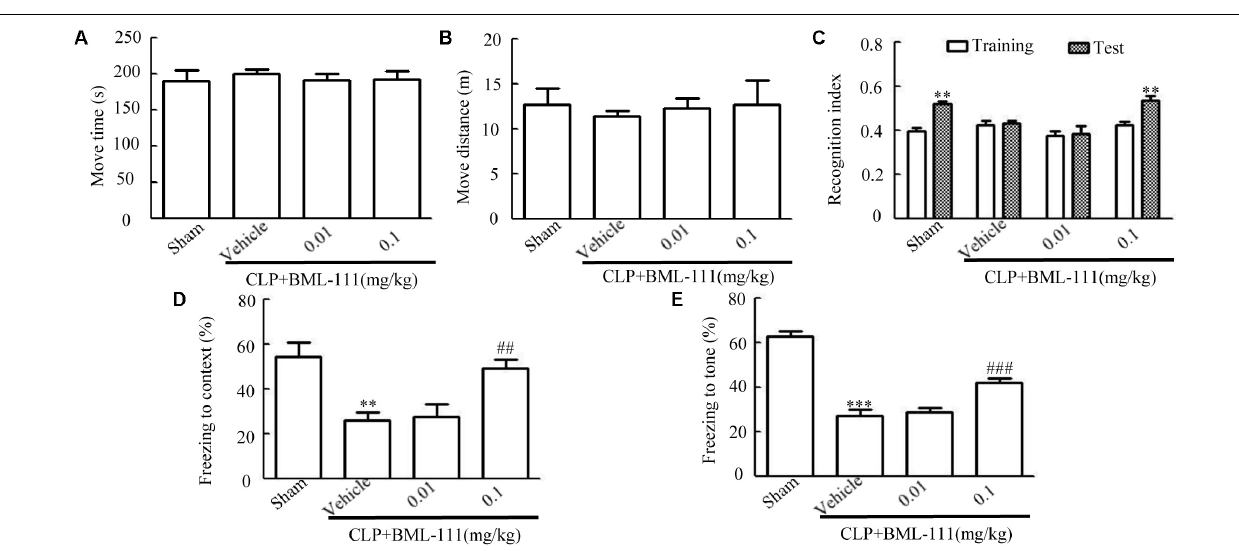
FIGURE 2 | Influences of BML-111 at different doses on cognitive dysfunction in mice with sepsis. BML-111 was injected intracerebroventricularly at doses of 0.01 and 0.1 mg/kg immediately after performing CLP. (A,B) No significant difference was observed in the move time and distance parameters in the open-field test. (C–E) Effects of BML-111 at different doses on novel-object-recognition and fear-conditioning tests results. Data were shown as the means ± SEM ( n = 10 surviving mice per group). ∗∗ P < 0.01 represents Test vs. Training in (C) . ∗∗ P < 0.01, ∗∗∗ P < 0.001 represent CLP + Vehicle vs. Sham and ## P < 0.01, ### P < 0.001 represents CLP + 0.1 mg/kg BML-111 vs. CLP + Vehicle in (D,E)